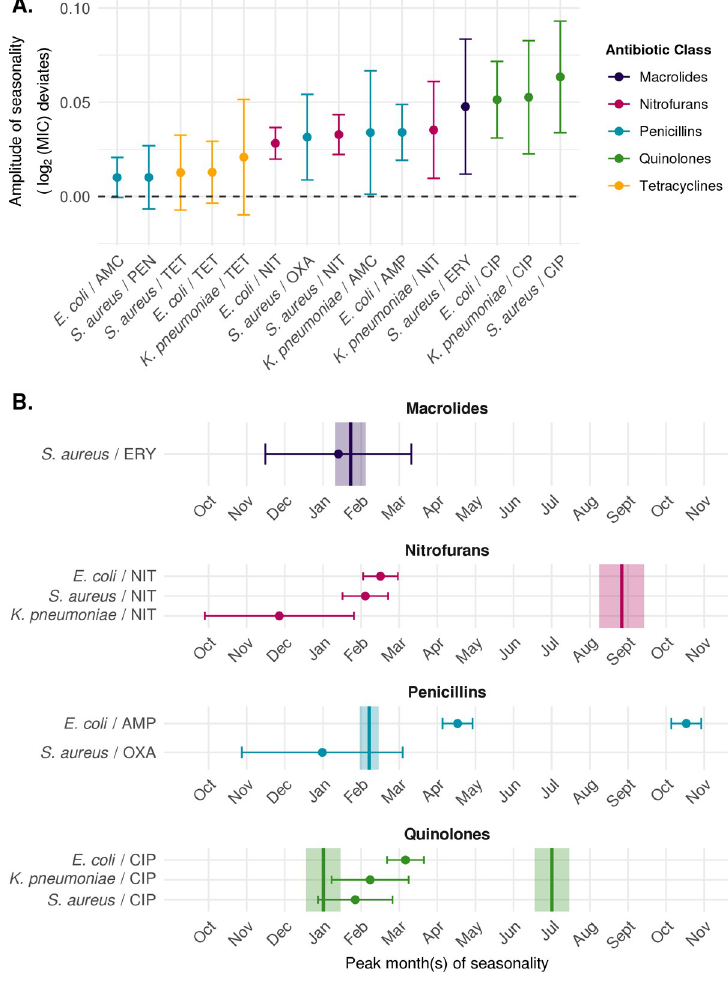
Fig 3. Amplitudes and phases of seasonality by species and antibiotic class. (A) Comparison of amplitudes estimated from best-fitting sinusoidal models of resistance (comparing 6- and 12-month periods) across antibiotics in Staphylococcus aureus , Escherichia coli , and Klebsiella pneumoniae . Error bars indicate 95% CIs of the amplitude. Point color indicates the antibiotic class. (B) Comparison of phases of seasonality of use and resistance across species and antibiotic classes. Points indicate peak month(s) of seasonal resistance estimated by the best-fitting sinusoidal model (comparing 6- and 12-month periods) for each species–antibiotic combination, and error bars indicate the 95% CIs. Included are species–antibiotic combinations for which the amplitude of seasonality of resistance was statistically significant (FDR < 0.05). Vertical lines indicate the peak month(s) of seasonal use estimated by the best-fitting sinusoidal model (comparing 6- and 12-month periods) for each antibiotic class, and shaded regions indicate the 95% CIs. AMC, amoxicillin-clavulanate; AMP, ampicillin; CIP, ciprofloxacin; ERY, erythromycin; FDR, false discovery rate; NIT, nitrofurantoin; OXA, oxacillin; PEN, penicillin; TET, tetracycline. Underlying data are available at https://github. com/gradlab/use-resistance-seasonality/tree/master/figure_data/Fig3